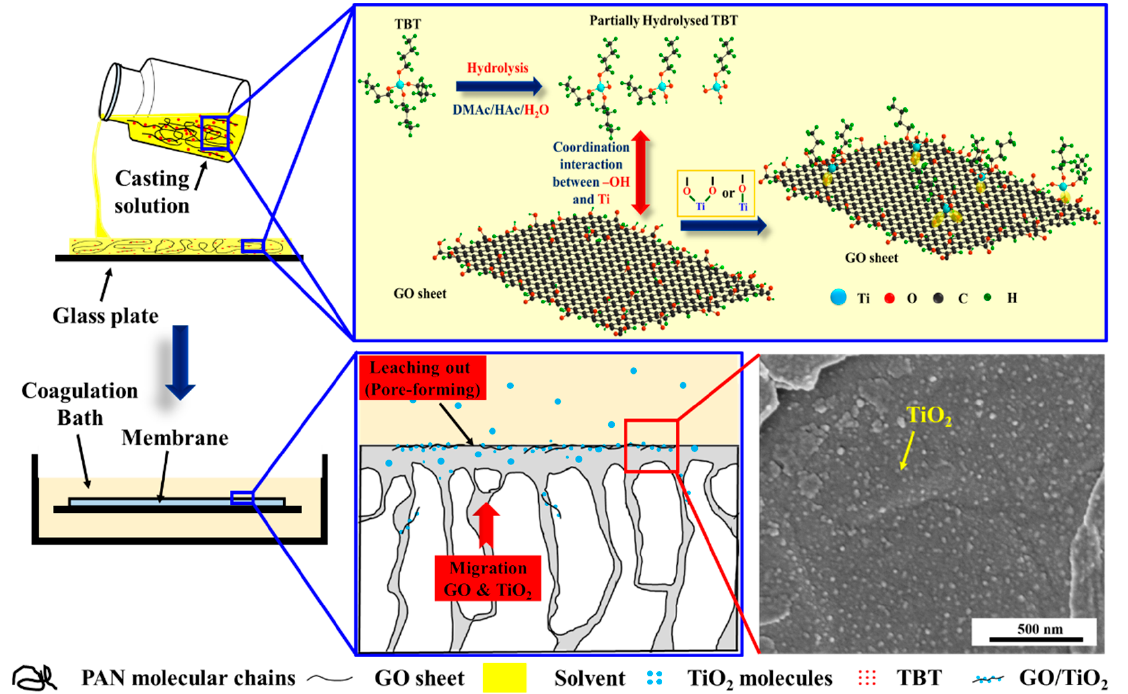
Figure 8. The schematic diagram of the membrane forming mechanism of the GO/TiO 2 /PAN membrane and the synergistic effects between the GO nanosheets and TiO 2 nanoparticles.